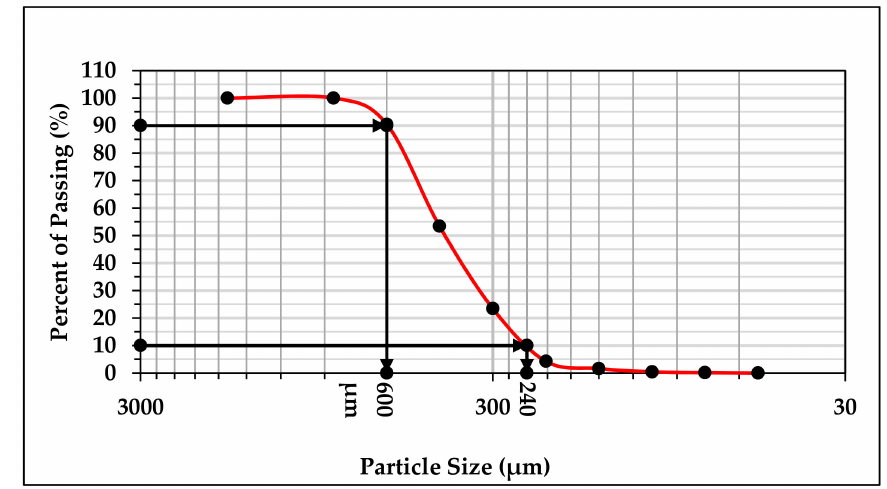
Figure 4. Particle size distribution